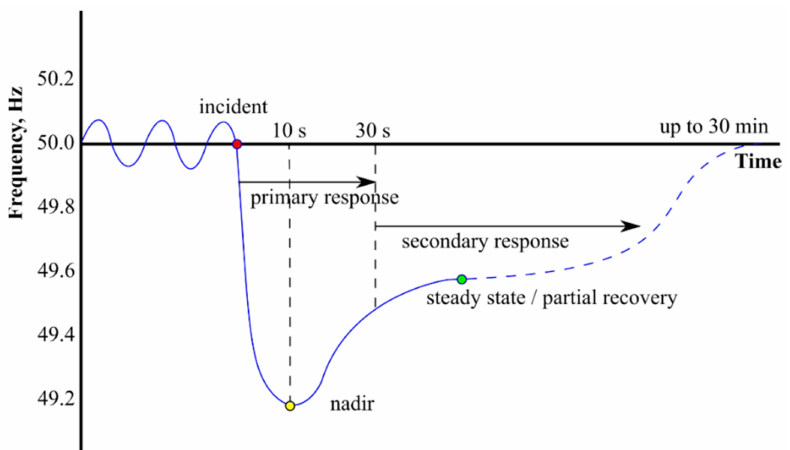
Figure 1. A typical frequency response rate to a disturbance identifying primary and secondary response rates (Reprinted with permission from ref. [20]. Copyright 2018